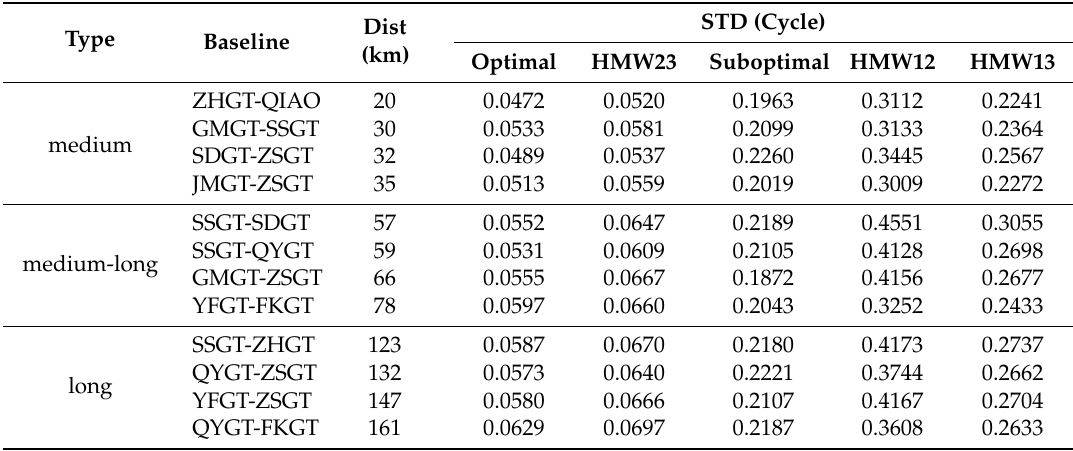
Table 7. Performance comparison for baselines with various lengths among the optimal, the HMW23, the suboptimal, the HMW12, and the HMW13